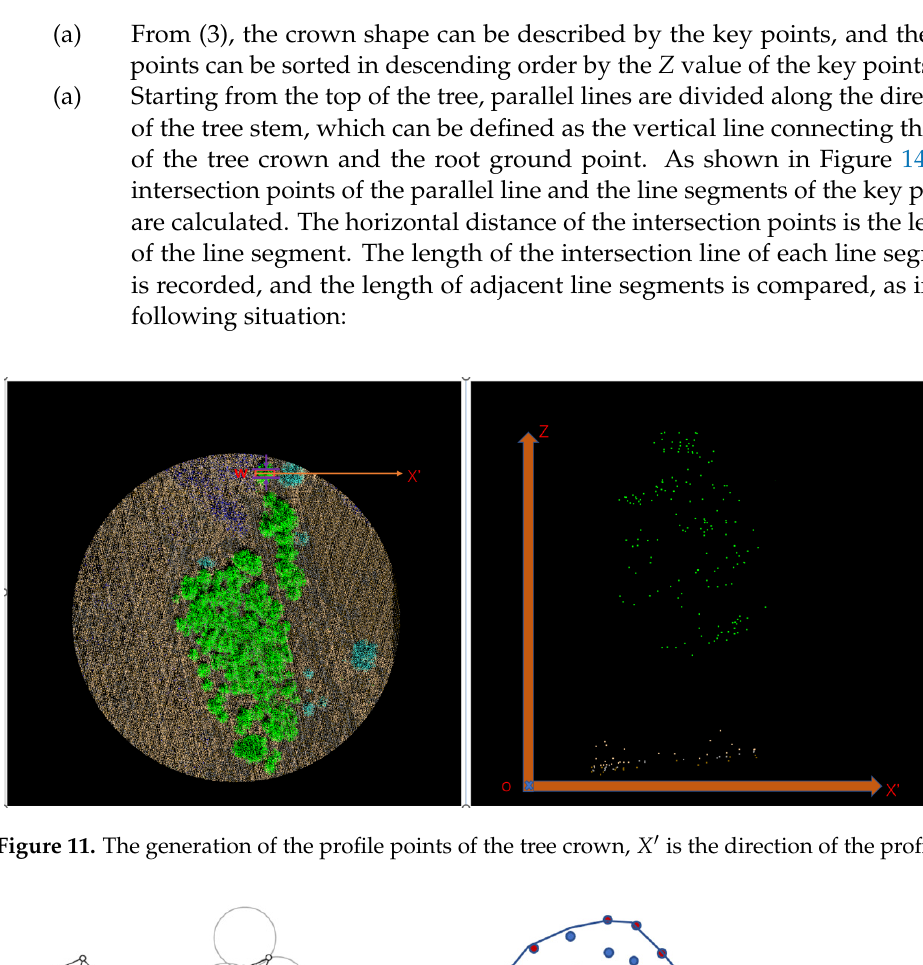
Figure 12. Using the alpha shapes algorithm to get the shape of the tree crown, and the red spots are the edge points.